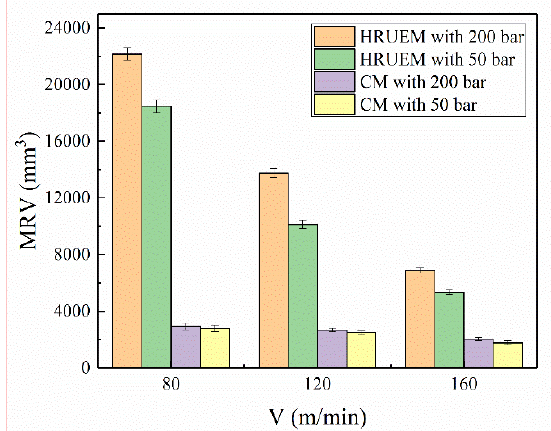
Figure 9. The variation of material removal volume (MRV) under different coolant pressures cooling conditions and cutting speeds in both HRUEM and CM.